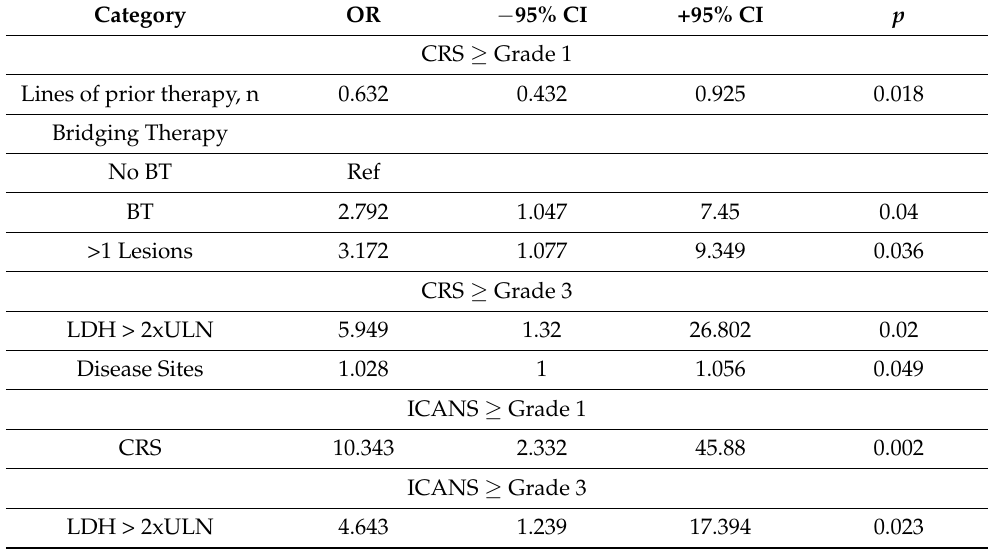
Table 5. Multivariable analysis of factors associated with CAR T-cell